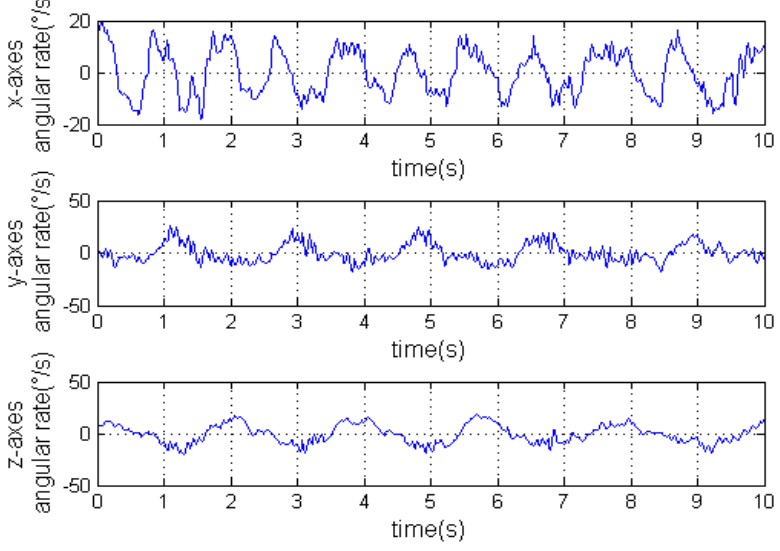
Figure 10. The angular rate.